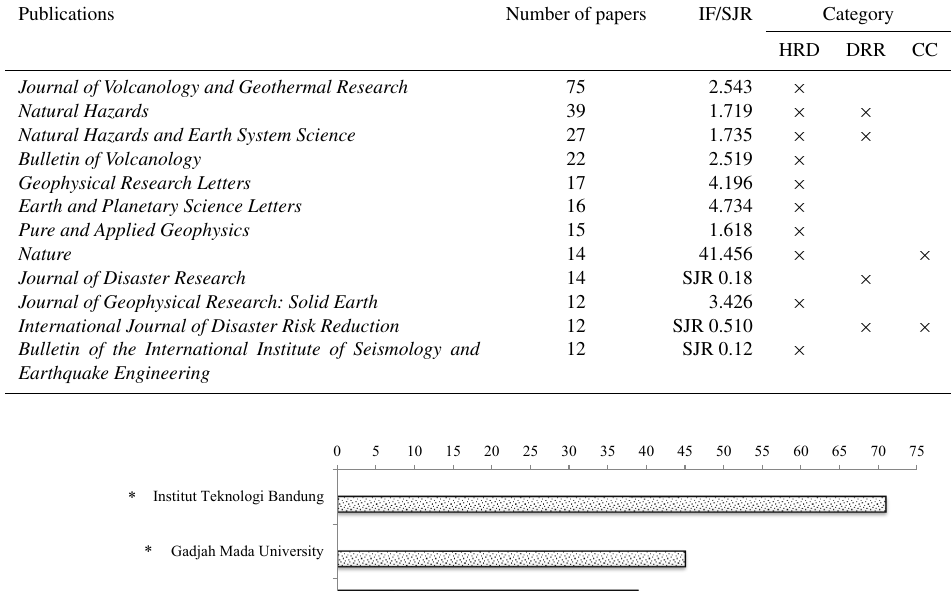
Table 4. List of most-submitted-to journals.